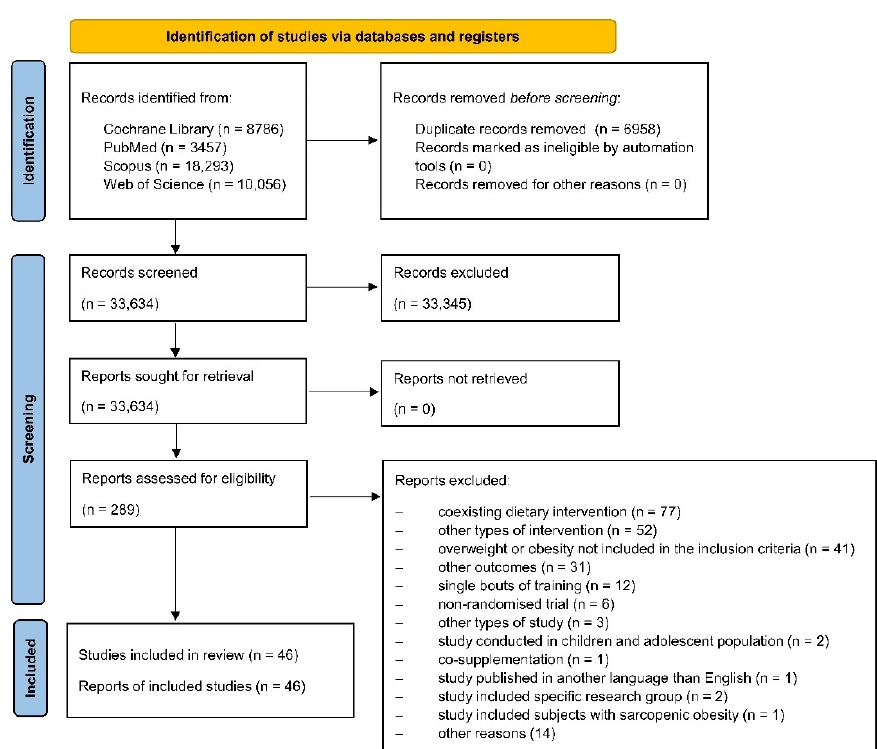
Figure 1. PRISMA 2020 flow diagram.